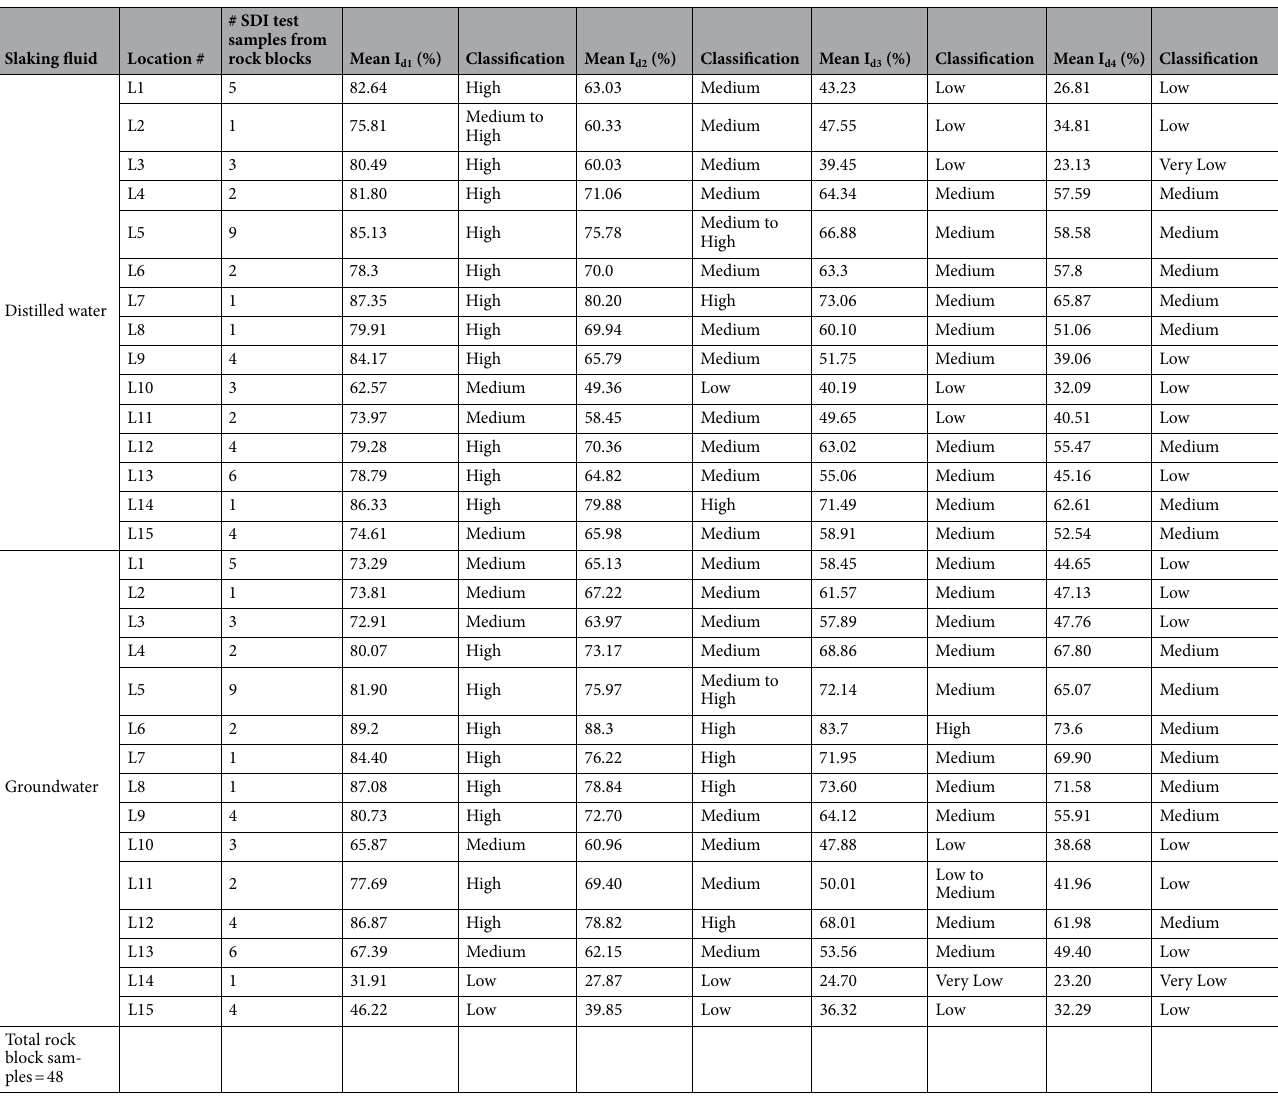
Table 3. Slake Durability Index (SDI) classification for each location using distilled water and groundwater as slaking fluid 1 . *Groundwater specification: Groundwater level = 10–40 m, Temperature = 21.5–31.2 (